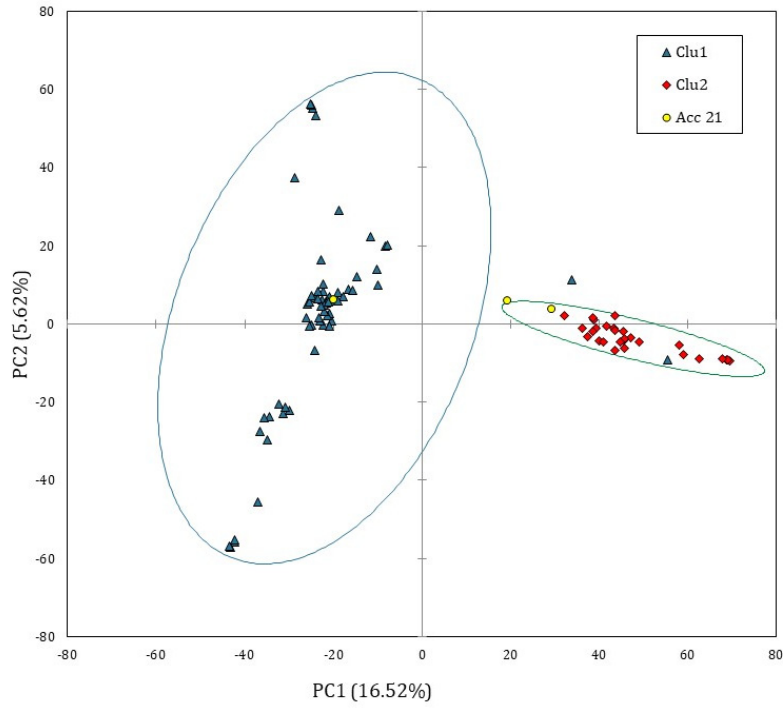
Figure 2. PCA score plot computed by using single Seed dataset (15,959 SNP markers and 93 geno- types). The ellipsis indicate the 95% confidence limit for each Solina cluster. The accession 21 was considered an